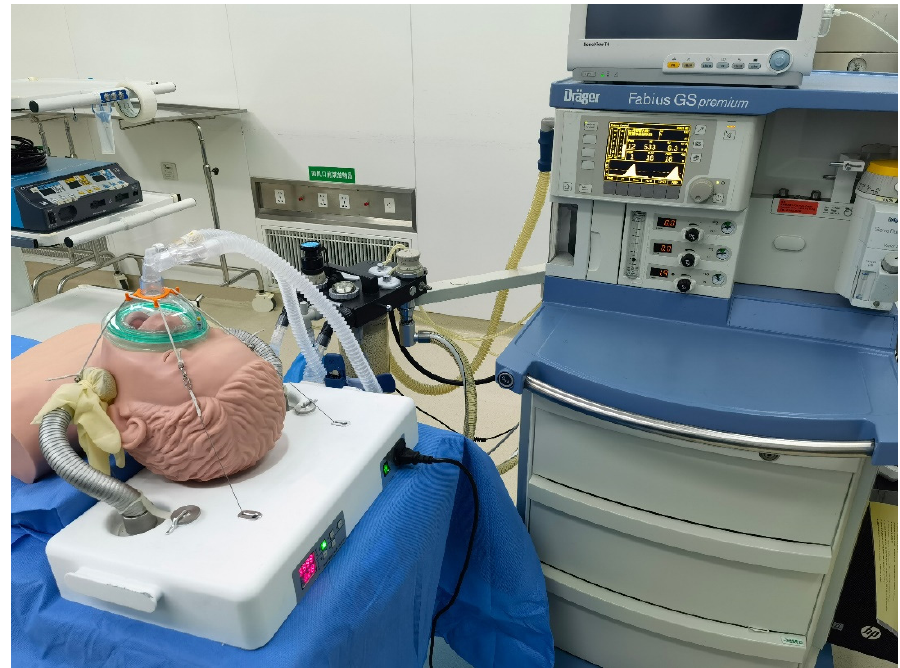
Figure 12. Simulation experiments of anesthesia airway management robot.